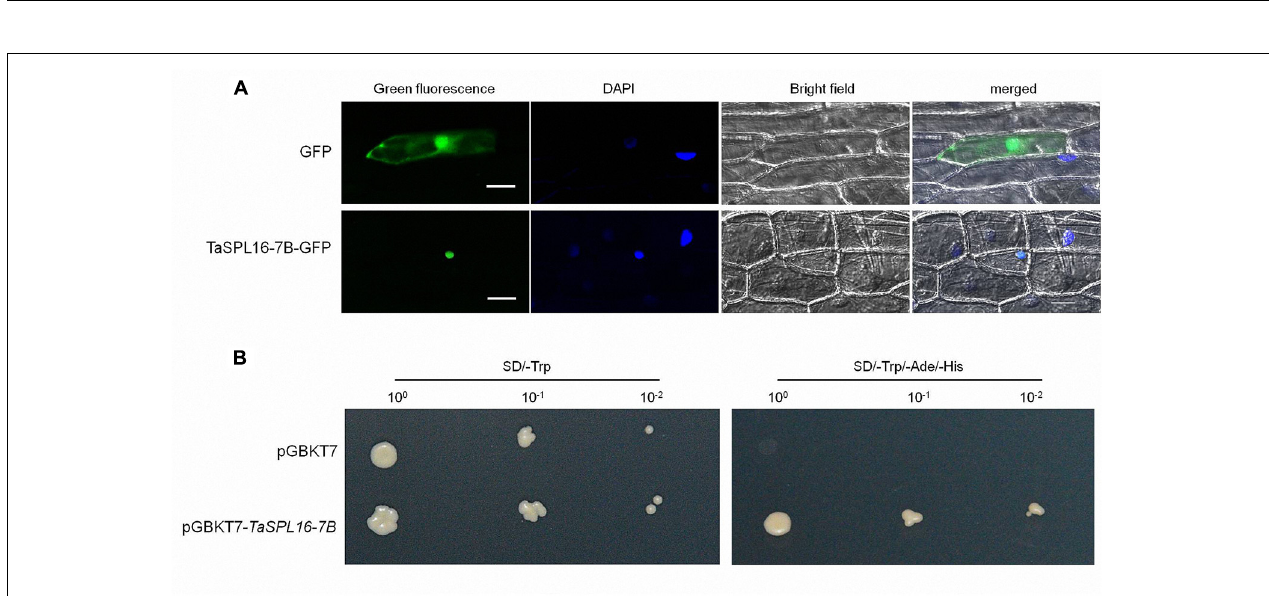
FIGURE 3 | Subcellular location and transcription activity analysis of TaSPL16-7B protein. (A) Subcellular location of TaSPL16-7B. Transient expression vector p35S:: TaSPL16-7B-GFP and control vector p35S:: GFP were introduced into onion epidermal cells. GFP and fusion protein TaSPL16-7B-GFP, and nucleus region were monitored by laser scanning confocal microscopy. DAPI, 4’, 6-diamidino-2-phenylindole, a blue-fluorescent DNA stain that used for indicating nucleus region; Bright field used as control for cell integrity; merges are the overlap of GFP and DAPI. Scale bars: 50 µ m. (B) Transcription activity analysis of TaSPL16-7B protein. The yeast colonies with three different dilution 10 − 1 , 10 − 2 , 10 − 3 were plated on the screening medium SD/-Trp and SD/-Trp/-Ade/-His, respectively. The empty pGBKT7 was used as a negative control. SD, Synthetic Dropout Medium; SD/-Trp, Trp-defective SD; SD/-Trp/-Ade/-His, Trp-, Ade-, and His-defective SD.